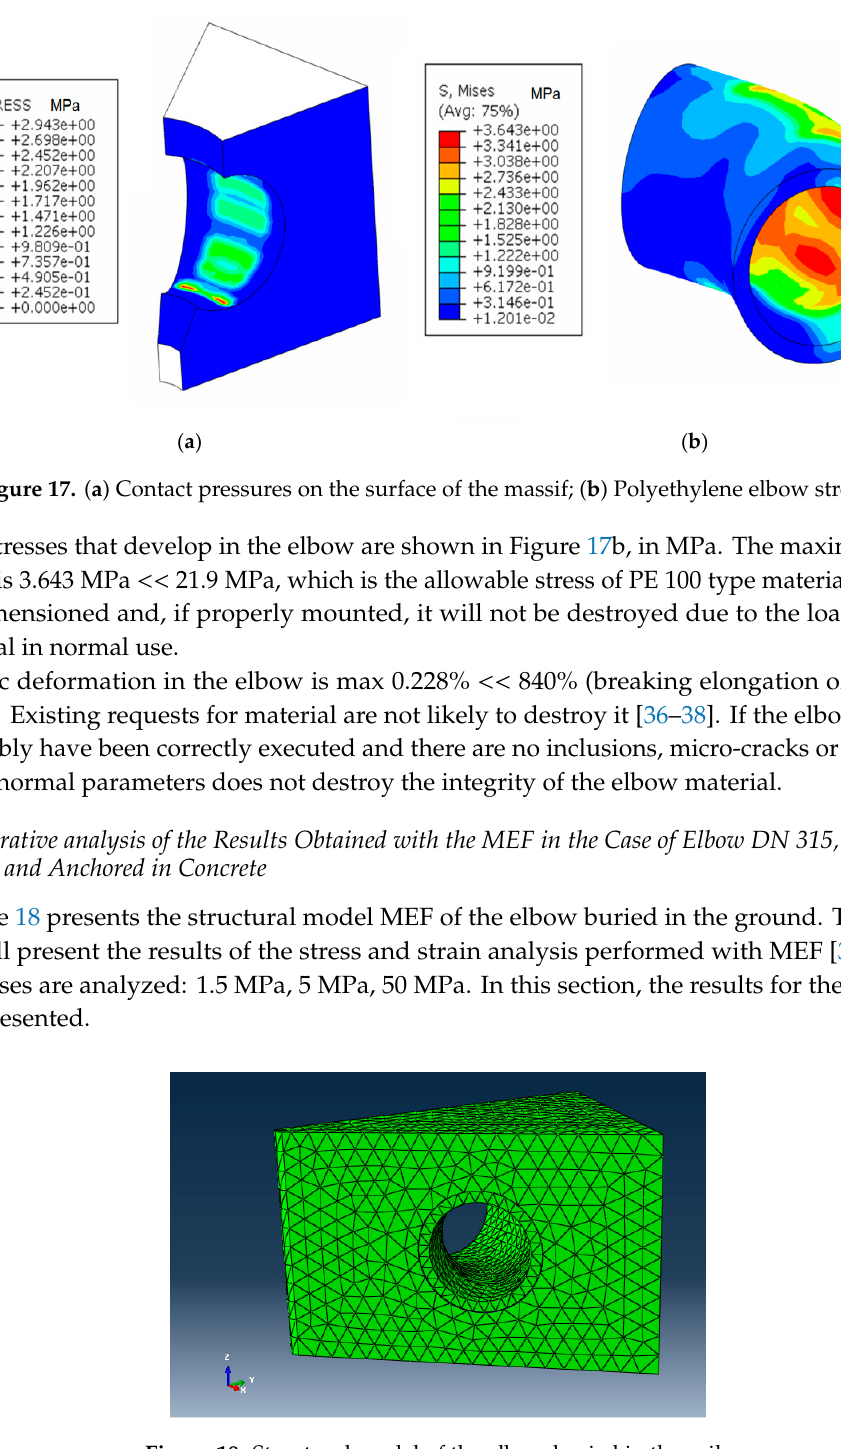
Figure 16. Stresses in the concrete massif.